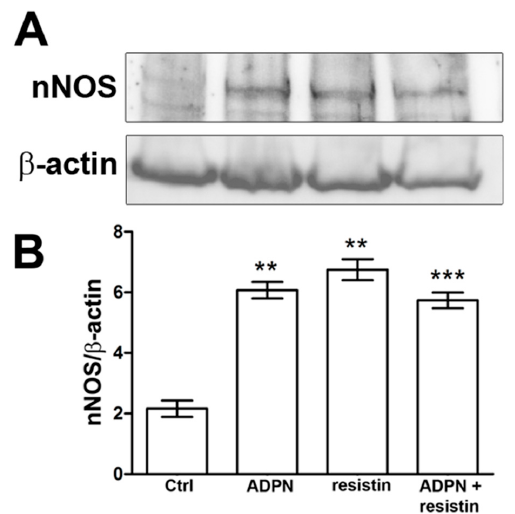
Figure 5. Effects of the different hormones on nNOS expression in the mouse gastric fundus assayed by Western blotting. ( A ) Representative bands from a typical experiment. ( B ) Quantitative analysis. Significance of differences (one-way ANOVA and Newman–Keuls post-test for multiple comparisons): ** p < 0.01 vs. controls (Ctrl) and p > 0.05 vs. adiponectin (ADPN) or resistin; *** p < 0.001 vs. Ctrl and p > 0.05 vs. ADPN or resistin. The reported data are expressed as the means ± SEM of 3 samples for each experimental group.